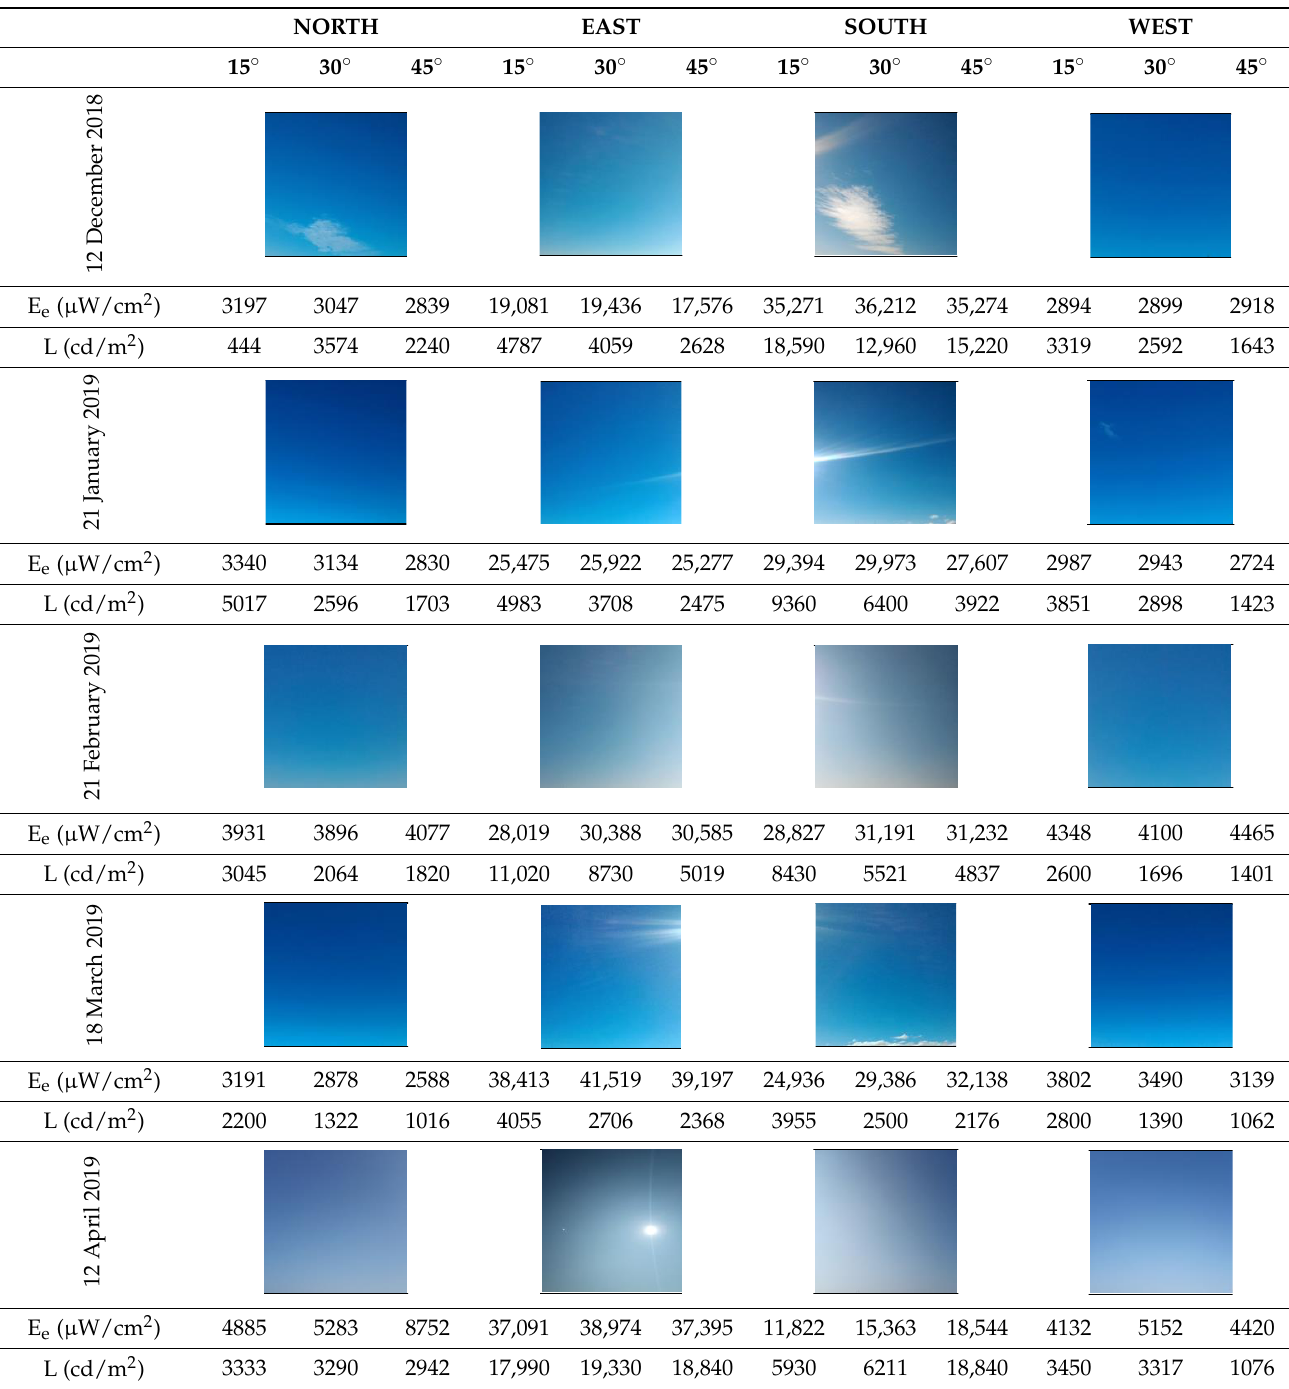
Table 1. Irradiance E e ( µ W/cm 2 ) and luminance L (cd/m 2 ) depending on the orientation (north, east, south, and west), elevation (15 ◦ , 30 ◦ , and 45 ◦ ) and seasonality. Table 1. Irradiance E e (µW/cm 2 ) and luminance L (cd/m 2 ) depending on the orientation (north, east, south, and west), Table 1. Irradiance E e (µW/cm 2 ) and luminance L (cd/m 2 ) depending on the orientation (north, east, south, and west), Table 1. Irradiance E e (µW/cm 2 ) and luminance L (cd/m 2 ) depending on the orientation (north, east, south, and west), Table 1. Irradiance E e (µW/cm 2 ) and luminance L (cd/m 2 ) depending on the orientation (north, east, south, and west), elevation (15°, 30°, and 45°) and seasonality. elevation (15°, 30°, and 45°) and seasonality. elevation (15°, 30°, and 45°) and seasonality. elevation (15°, 30°, and 45°) and seasonality. Table 1. Irradiance E e (µW/cm 2 ) and luminance L (cd/m 2 ) depending on the orientation (north, east, south, and west), Table 1. Irradiance E e (µW/cm 2 ) and luminance L (cd/m 2 ) depending on the orientation (north, east, south, and west), Table 1. Irradiance E e (µW/cm 2 ) and luminance L (cd/m 2 ) depending on the orientation (north, east, south, and west), Table 1. Irradiance E e (µW/cm 2 ) and luminance L (cd/m 2 ) depending on the orientation (north, east, south, and west), NORTH EAST SOUTH WEST elevation (15°, 30°, and 45°) and seasonality. elevation (15°, 30°, and 45°) and seasonality. elevation (15°, 30°, and 45°) and seasonality. elevation (15°, 30°, and 45°) and seasonality. Table 1. Irradiance E e (µW/cm 2 ) and luminance L (cd/m 2 ) depending on the orientation (north, east, south, and west), Table 1. Irradiance E e (µW/cm 2 ) and luminance L (cd/m 2 ) depending on the orientation (north, east, south, and west), Table 1. Irradiance E e (µW/cm 2 ) and luminance L (cd/m 2 ) depending on the orientation (north, east, south, and west), Table 1. Irradiance E e (µW/cm 2 ) and luminance L (cd/m 2 ) depending on the orientation (north, east, south, and west), NORTH EAST NORTH EAST NORTH EAST elevation (15°, 30°, and 45°) and seasonality. elevation (15°, 30°, and 45°) and seasonality. elevation (15°, 30°, and 45°) and seasonality. elevation (15°, 30°, and 45°) and seasonality. Table 1. Irradiance E e (µW/cm 2 ) and luminance L (cd/m 2 ) depending on the orientation (north, east, south, and west), Table 1. Irradiance E e (µW/cm 2 ) and luminance L (cd/m 2 ) depending on the orientation (north, east, south, and west), Table 1. Irradiance E e (µW/cm 2 ) and luminance L (cd/m 2 ) depending on the orientation (north, east, south, and west), Table 1. Irradiance E e (µW/cm 2 ) and luminance L (cd/m 2 ) depending on the orientation (north, east, south, and west), NORTH elevation (15°, 30°, and 45°) and seasonality. elevation (15°, 30°, and 45°) and seasonality. elevation (15°, 30°, and 45°) and seasonality. Table 1. Irradiance E elevation (15°, 30°, and 45°) and seasonality. Table 1. Irradiance E e (µW/cm 2 ) and luminance L (cd/m 2 ) depending on the orientation (north, east, south, and west), Table 1. Irradiance E e (µW/cm 2 ) and luminance L (cd/m 2 ) depending on the orientation (north, east, south, and west), Table 1. Irradiance E e (µW/cm 2 ) and luminance L (cd/m 2 ) depending on the orientation (north, east, south, and west), e (µW/cm 2 ) and luminance L (cd/m 2 ) depending on the orientation (north, east, south, and west), elevation (15°, 30°, and 45°) and seasonality. elevation (15°, 30°, and 45°) and seasonality. elevation (15°, 30°, and 45°) and seasonality. elevation (15°, 30°, and 45°) and NORTH EAST SOUTH WEST NORTH EAST SOUTH WEST